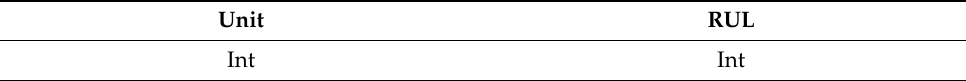
Table 3. The data structure of the RUL